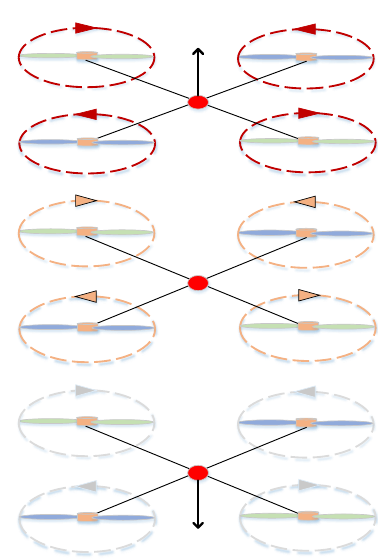
Figure 1. The longitudinal movement principle of quadrotor